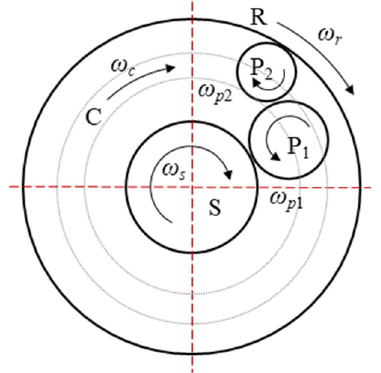
Figure 4. Kinematic diagram of the D-PGT.